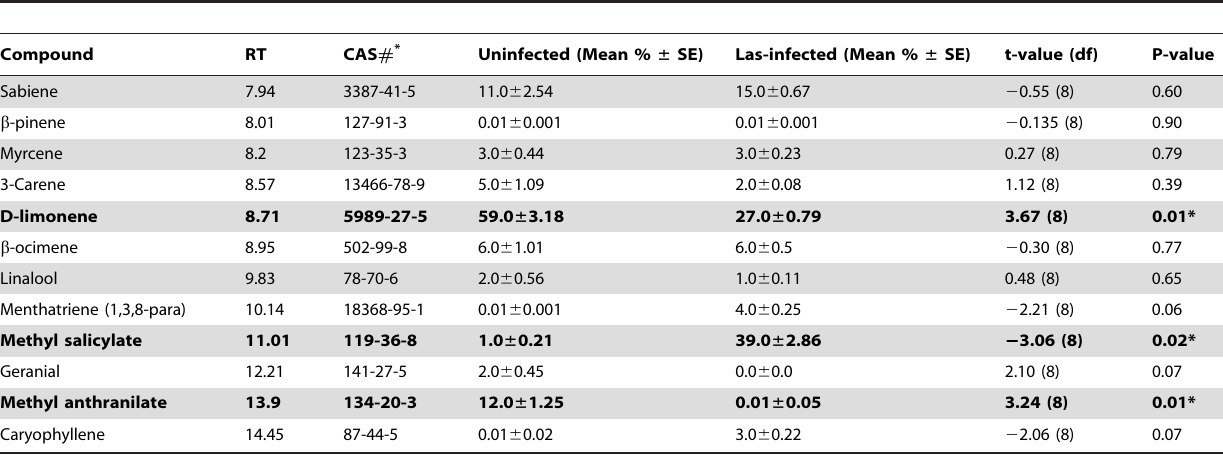
Table 3. Volatiles from Las-infected and non-infected citrus plants presented as average percentage 6 1 standard error (SE) of n- octane equivalents of volatile organic compounds collected from plants’ headspace.